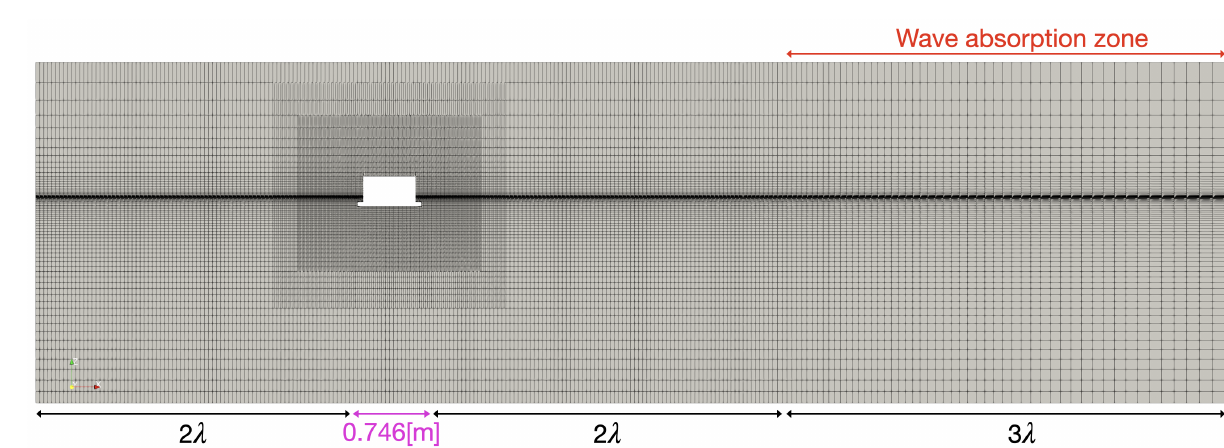
Figure 6. Generated mesh of the middle plane.